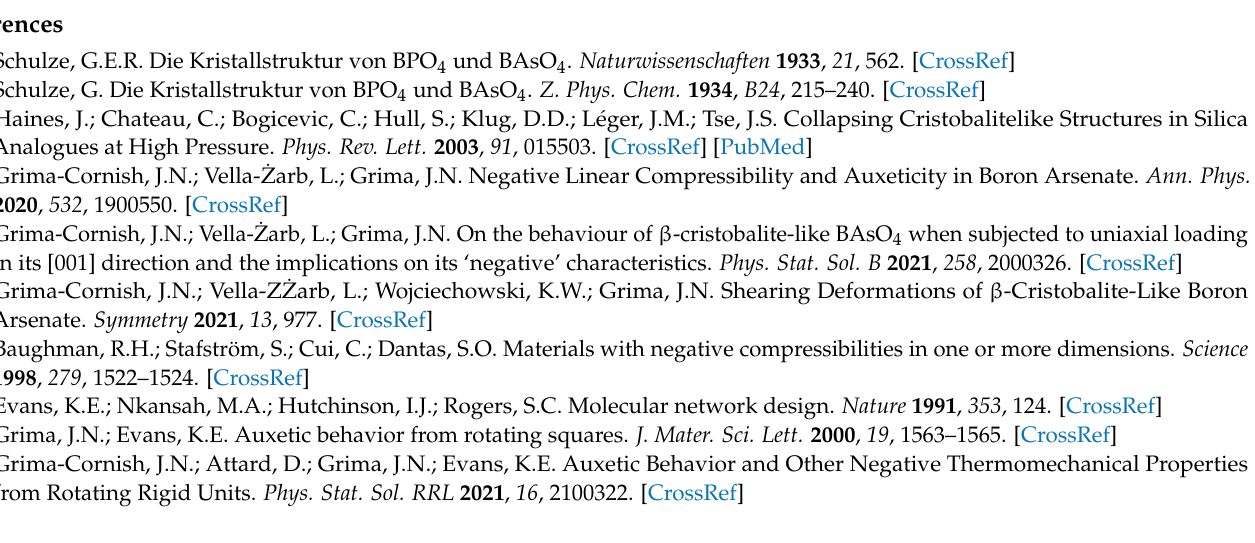
Figure A1. X-ray diffraction spectra ( a – d ) for the structure of BAsO 4 corresponding to the systems at pressure p = − 15GPa, 15GPa, 45GPa and 75GPa calculated using the Reflex module in Materials Studio. Note that changes in the crystal structure are very evident from the differences in reflections/peak positions.